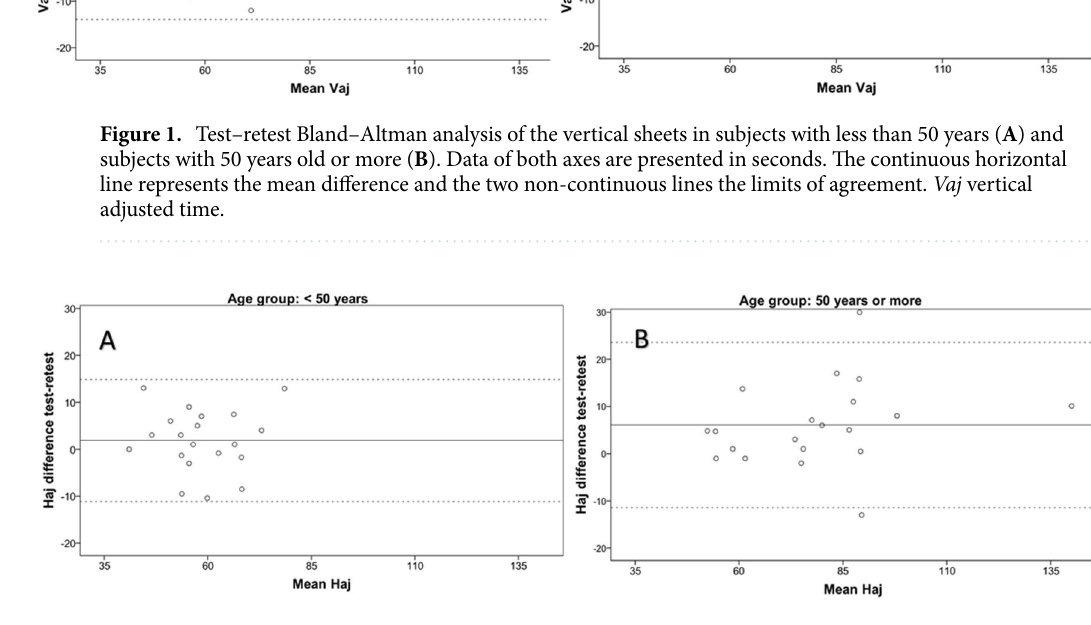
Figure 2. Test–retest Bland–Altman analysis of the horizontal sheet in subjects with less than 50 years ( A ) and subjects with 50 years old or more ( B ). Data of both axes are presented in seconds. The continuous horizontal line represents the mean difference and the two non-continuous lines the limits of agreement. Haj horizontal adjusted time.